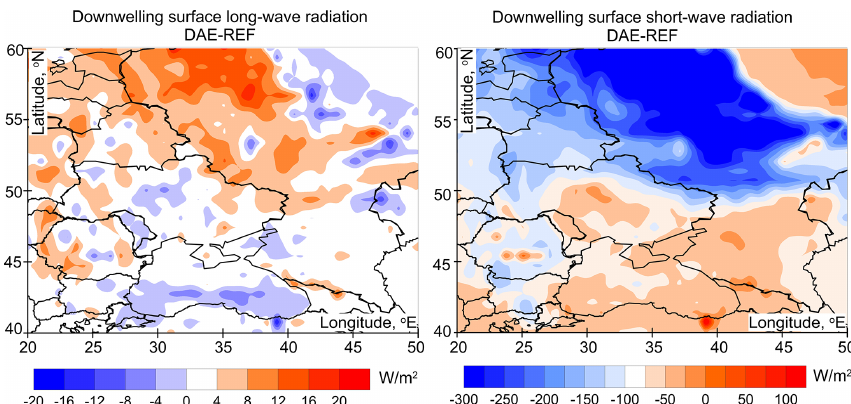
Figure 7. Difference fields between the Enviro-HIRLAM DAE and REF model runs for downwelling surface long-wave and short-wave radiation at 12:00UTC on 14 August